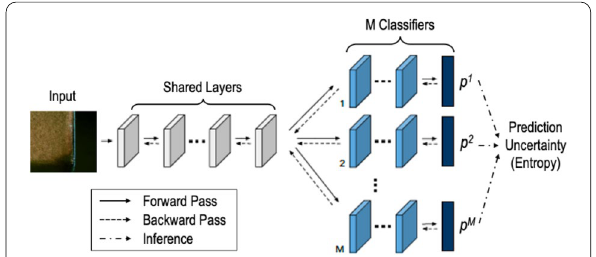
Figure 6 Multi-head network, adapted from Ref.